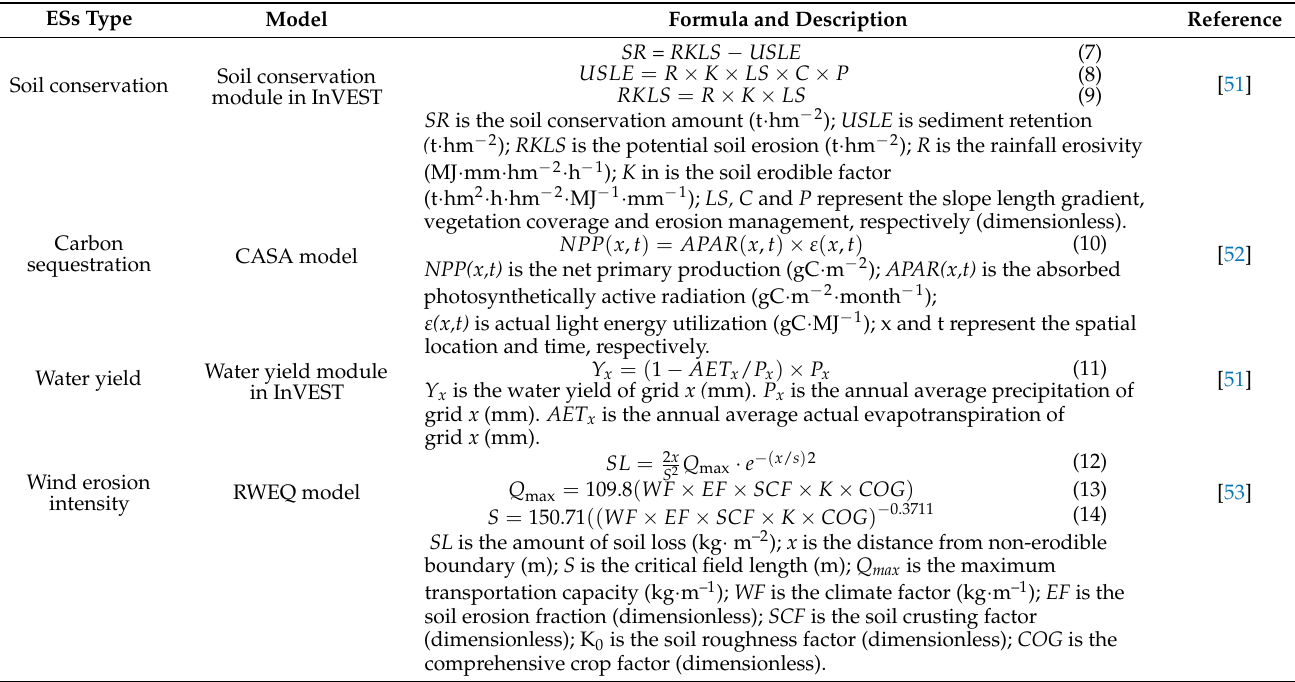
Table 2. Ecosystem service assessment